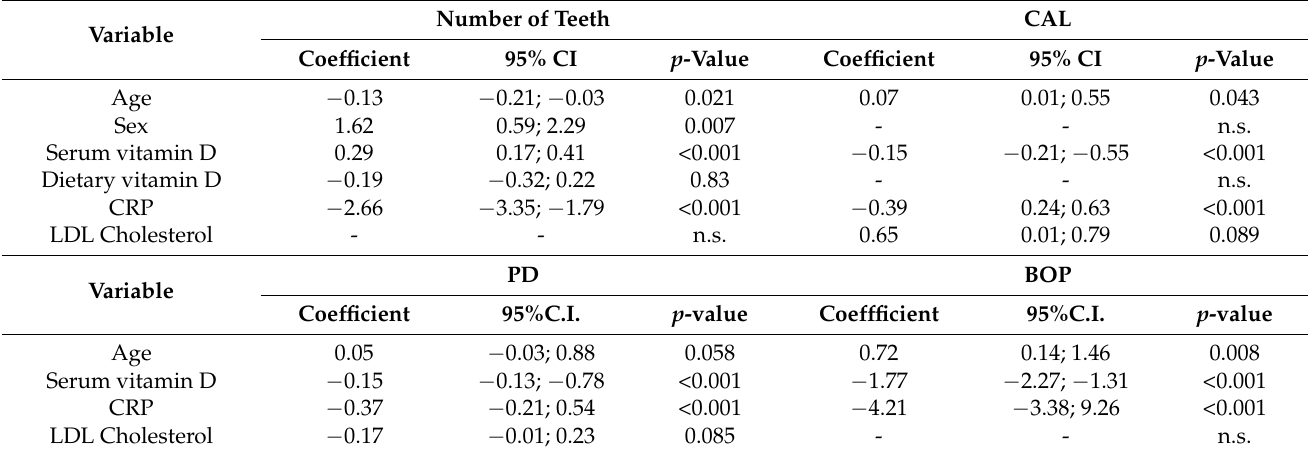
Table 3. Stepwise linear regression models established for the number of teeth and periodontal indices. Age, vitamin D, dietary vitamin D, CRP, and LDL cholesterol were included as a continuous variable. For gender, female served as reference.